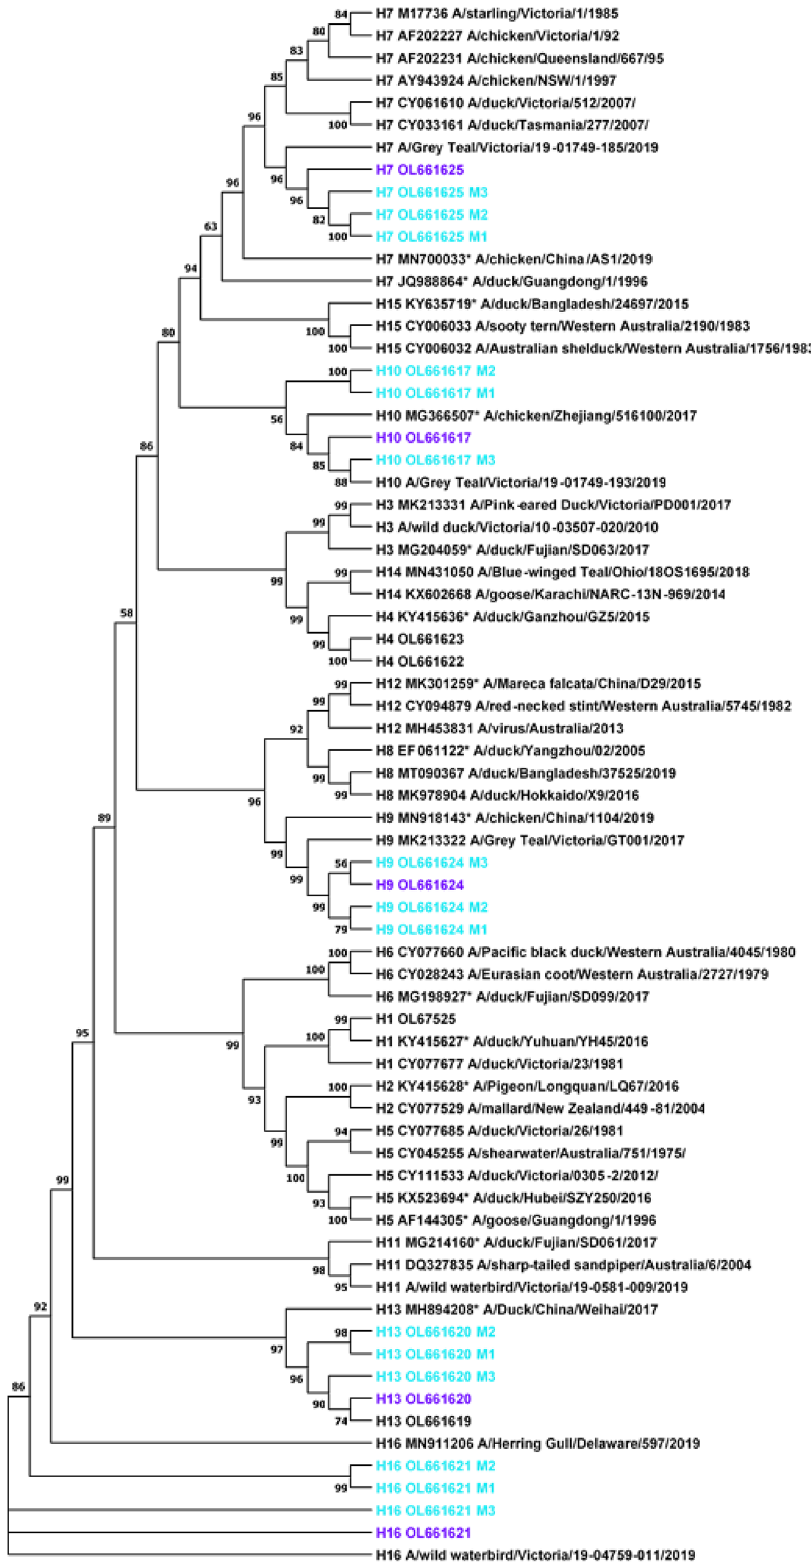
Figure 5. An unrooted maximum likelihood (ML) of 55 avian influenza A virus haemagglutinin sequences (Table1A and B, excluding H17) worldwide obtained from MEGA11. The ML tree shows all 16 influenza subtypes as their own unique clades. Bootstrap values below 50% are not shown. All consensus HA sequences generated in this study are indicated with a light teal colour and the following nomenclature for the different pipeline methods—M1- CAP3, M2- Geneious de novo, M3- Geneious reference mapping. Corresponding Illumina sequences are indicated with purple. Exotic strains are denoted with *. All other strains are Australian unless otherwise stated in the study. Pairwise patristic distance of sequences can be found in Supplementary Data